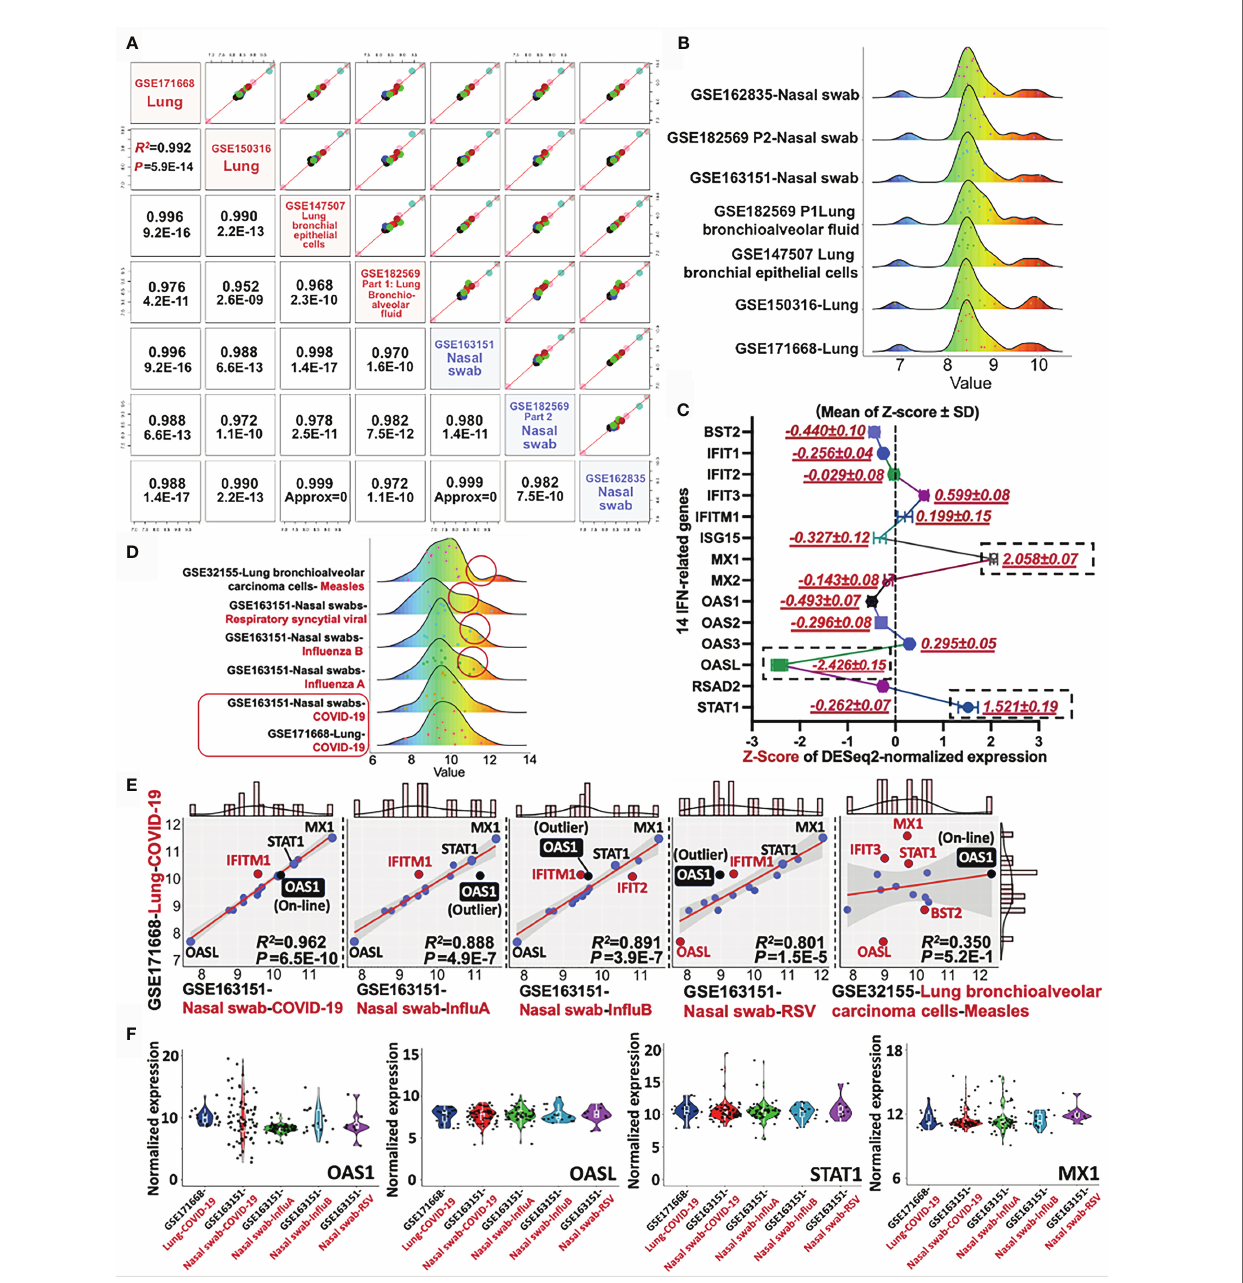
FIGURE 6 | Differential diagnosis of COVID-19 with other respiratory infectious diseases by a 14-gene expression pro fi le. (A) Pairwise analysis of gene pro fi le in heterogeneous samples in COVID-19, including four nasal swabs (GSE163151, GSE162835, and GSE162835); two lung tissues (GSE171668 and GSE150316), and one lung bronchial epithelial cells (GSE147507). Pearson ’ s correlation coef fi cient R and P-value are shown in red. (B) Trendgram of normalized 14-gene expression in heterogeneous samples infected by SARS-CoV-2. (C) Representative trendgram from SARS-CoV-2 infected samples. It is quantitatively mapped by Z-score normalization of gene expression from databases shown in panel (A) . The three rectangles represent the absolute value of Z-score with large variations from the baseline (Top 3). (D) Representative Trendgram of COVID-19 and other respiratory diseases (In fl uenza A, In fl uenza B, RSV, and Measles). Red circles indicate the distinct peak trend when compared with that of COVID-19. (E) The linear relationship between COVID-19 and other respiratory infections, in which the outlier genes are shown in red. In particular, the point of OAS1 is highlighted in black. The value of Pearson ’ s R- square and P value between datasets are indicated in the right bottom panel. (F) Violin plots shown the normalized expression of OAS1, OASL, STAT1, and MX1 from various